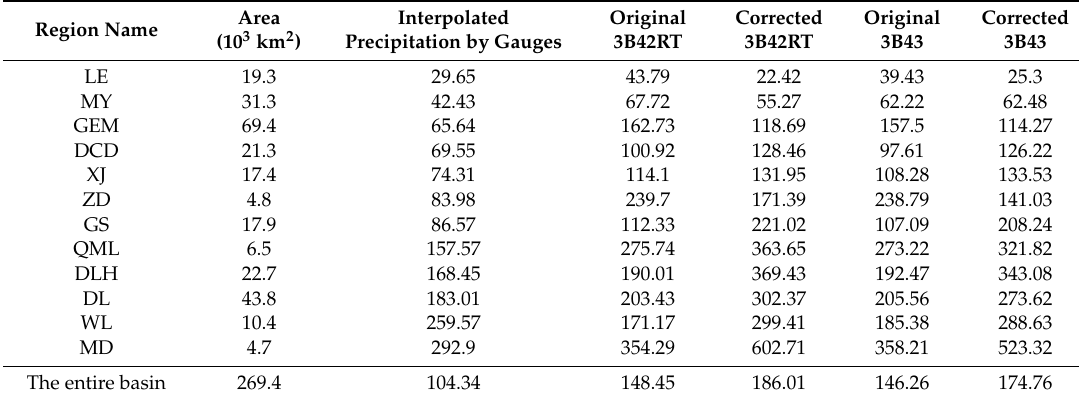
Table 3. Assessment of annual precipitation in each region of the Qaidam